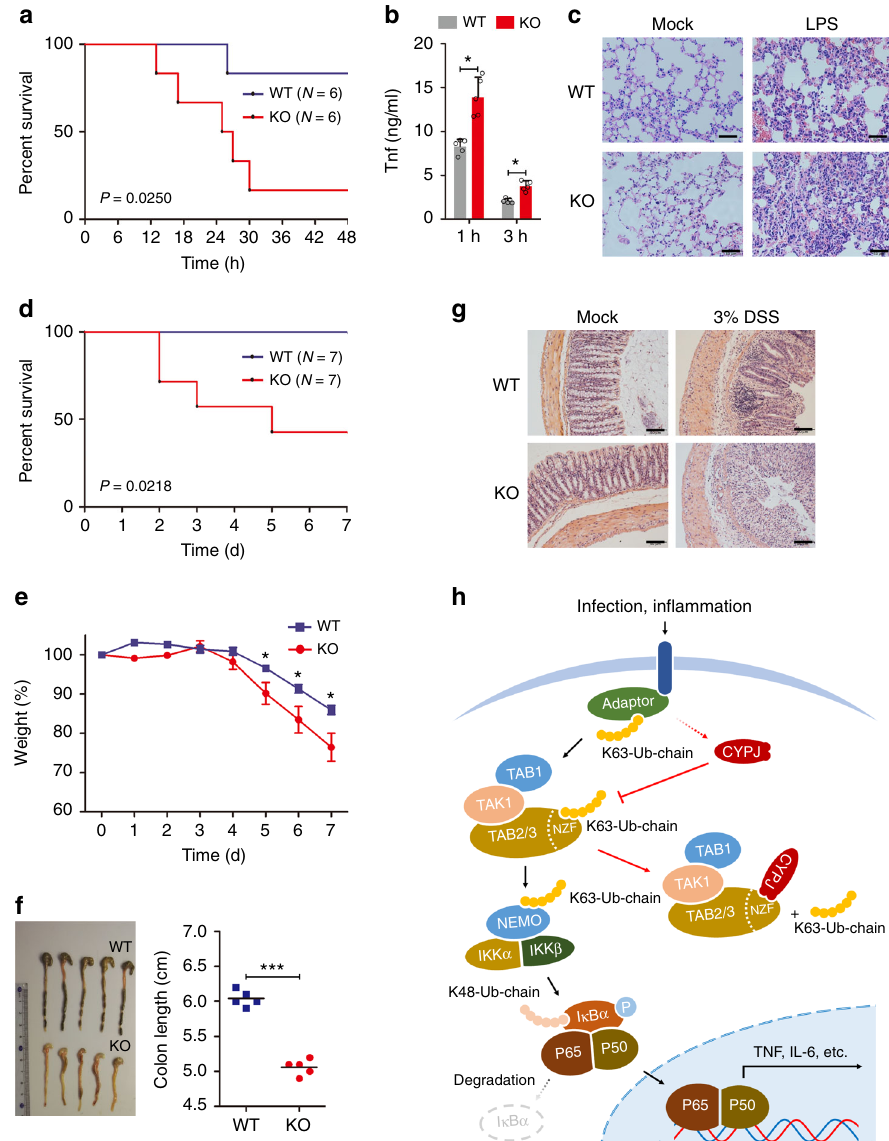
Fig. 7 Cypj protects mice from lethal acute in fl ammation and DSS-colitis. a , b Survival curve ( a N = 6 mice per group, Log-rank Test) and ELISA of serum Tnf level ( b N = 5 mice per group, two-tailed Student ’ s t -test) in Cypj-de fi cient and WT mice after intraperitoneal injection of LPS (10 mg per kg body weight). c Histopathology of lungs from Cypj-de fi cient and control mice after intraperitoneal injection of LPS (10 mg kg − 1 ). Scale bars, 100 μ m. d Survival curve ( N = 7 mice per group, Log-rank test) of WT and Cypj KO mice after intraperitoneal injection of HKLM (2 × 10 12 CFU per mice). e Weight loss during 3% DSS-induced colitis was expressed as the percentage of change from day 0 ( N = 5 mice per group, two-tailed Student ’ s t -test). f Colon lengths of DSS- treated mice ( N = 5 mice per group, two-tailed Student ’ s t -test) were assessed at the time of necropsy, with representative macroscopic images and statistics. g Representative micrographs of colon hematoxylin and eosin (H&E) staining from WT and KO mice 7 days after DSS-colitis. Scale bars, 100 μ m. h Proposed working model of CYPJ dependent negative feedback regulation of the NF- κ B signal pathway. Error bars indicate S.D.; * p < 0.05, *** p <